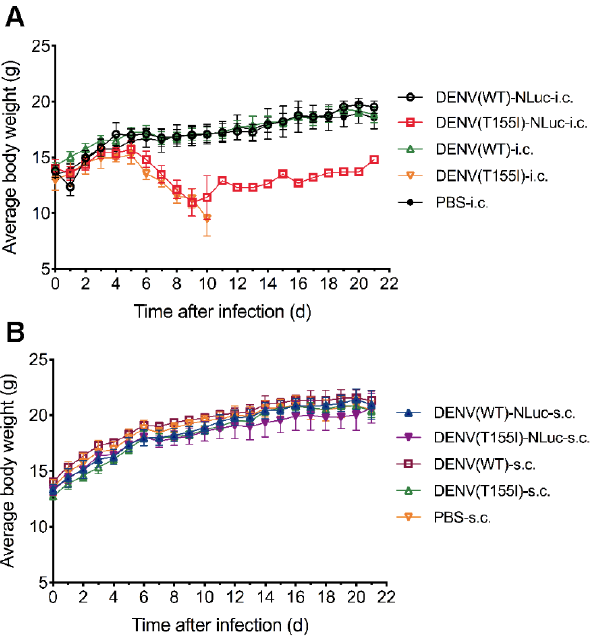
Figure 6. Body weight monitoring of 4-week-old BALB/c mice injected with prototype and reporter DENVs. ( A ) BALB/c mice (n = 5) were injected intracerebrally with 0.03 mL of virus (4.4 lg PFU). ( B ) BALB/c mice (n = 5) were injected subcutaneously with 0.1 mL of virus (5.0 lg PFU) and intracerebrally (right side) with PBS. Body weight of mice was monitored daily.